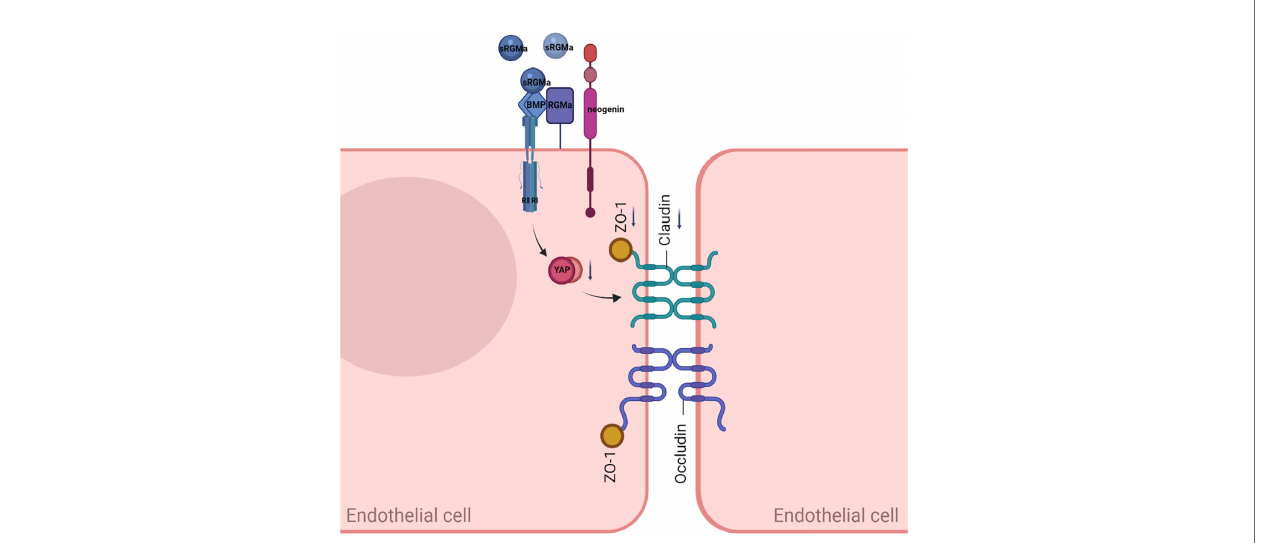
FIGURE 9 | A proposed model of RGMa regulation of BMP2/BMPR II/YAP signaling in endothelial cells. The overexpression of RGMa forms a complex by binding BMP2 and BMPR II, then attenuates YAP expression, which promotes the disruption of the BBB. By regulating the BMP2/BMPR II/YAP pathway, RGMa mediates dysfunction of the blood – brain